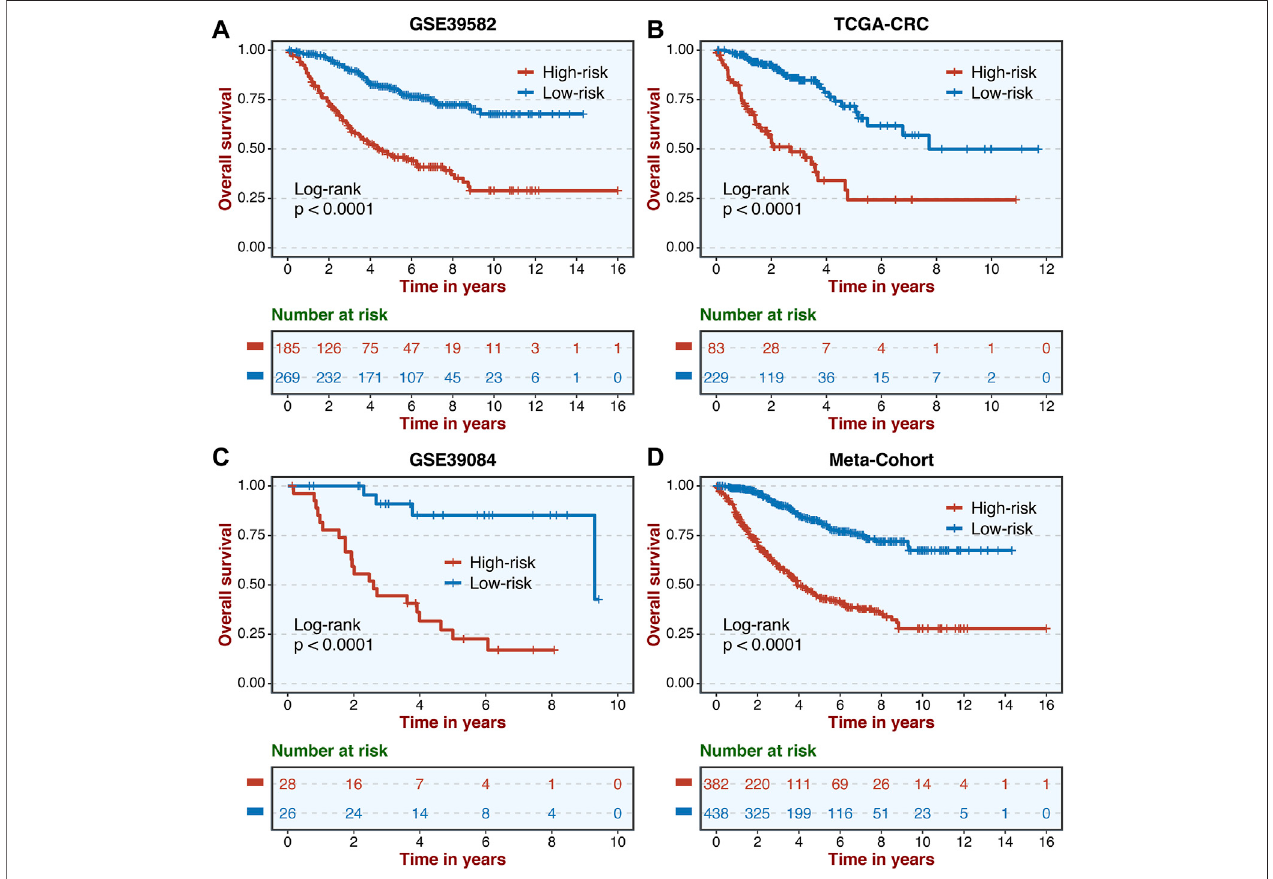
FIGURE 3 | Kaplan – Meier analysis of OS according to MSSAS. Kaplan – Meier curves of OS according to the MSSAS in GSE39582 (A) , TCGA – CRC (B) , GSE39084 (C) , and Meta-Cohort (D) .